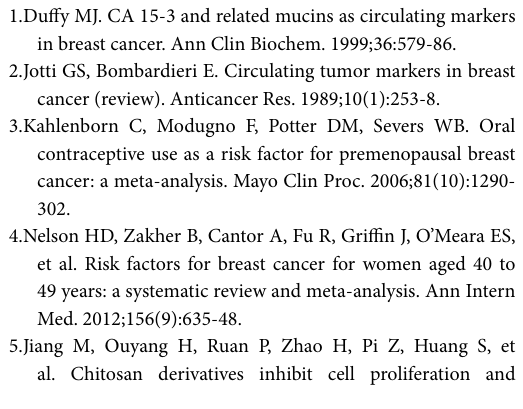
Fig. 6. 4T1 Xenograft tumor cells growth( average volume of the tumor (mm 3 ) ± standard error).